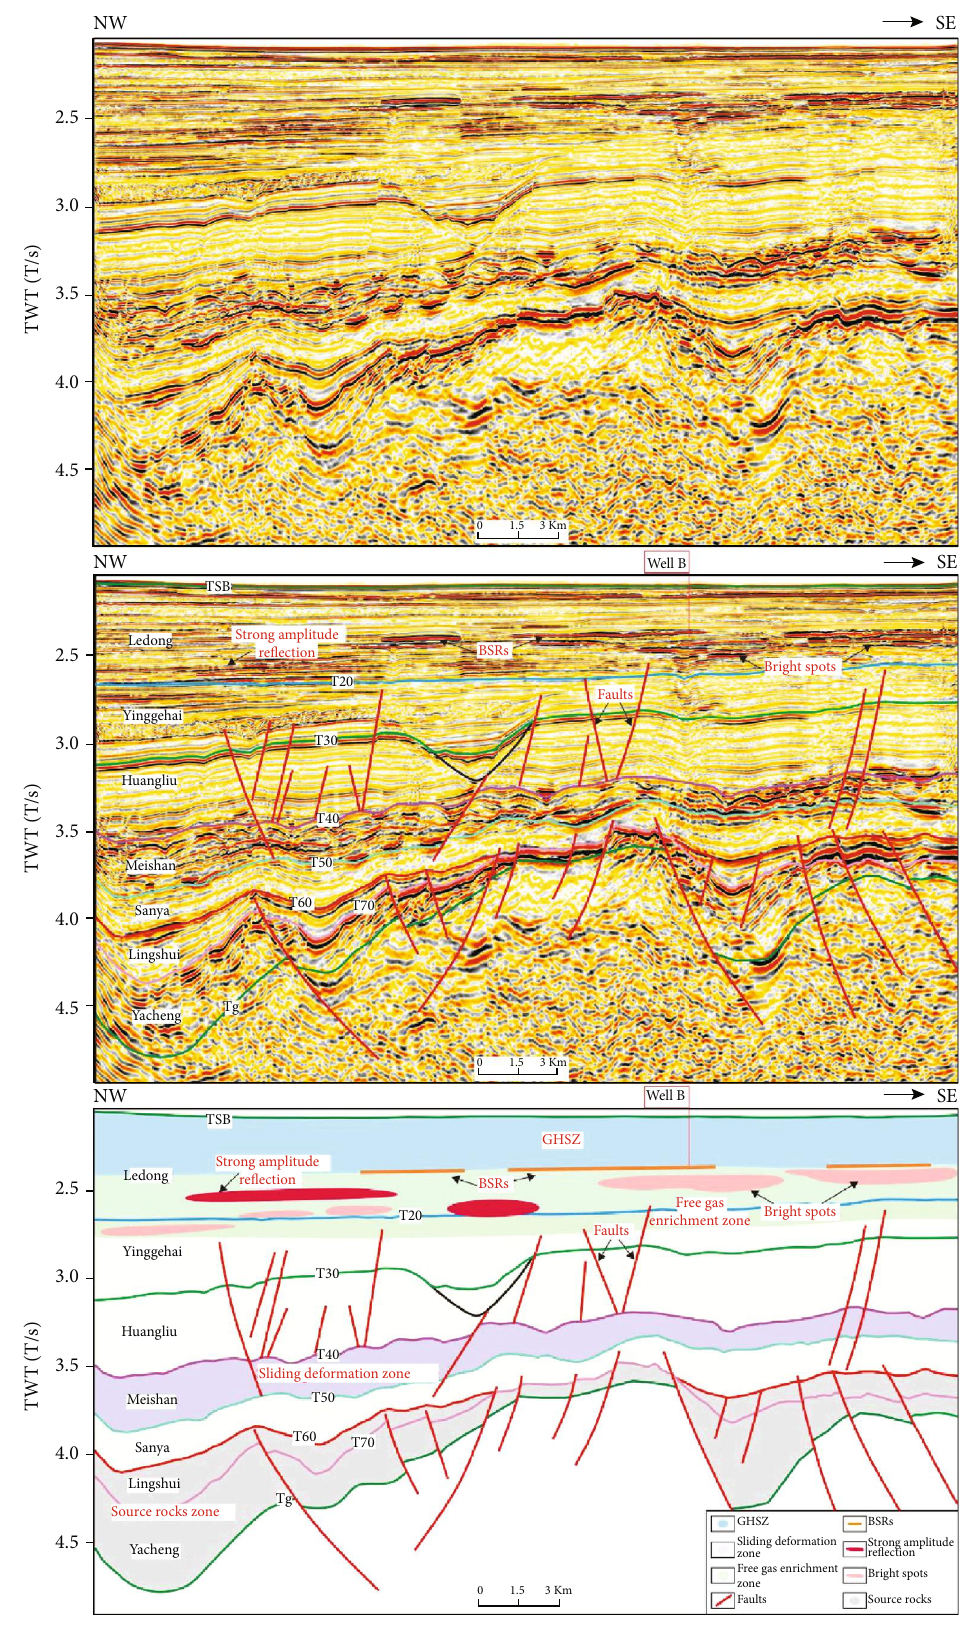
Figure 4: Fault structure shown in the seismic pro fi le of line 2 in the QDNB (pro fi le location is shown in Figure